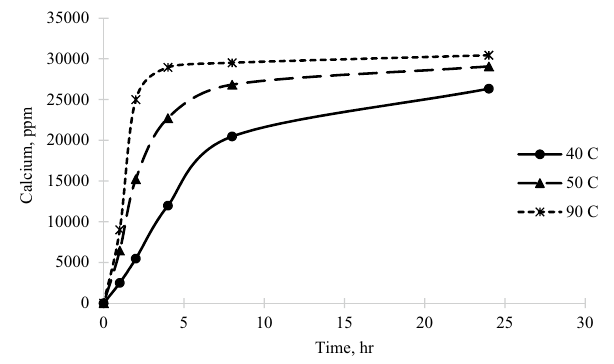
Fig. 5 Dissolution study of mixed scale Sample 2 with MAPE–ASA– DLABSA–GE system